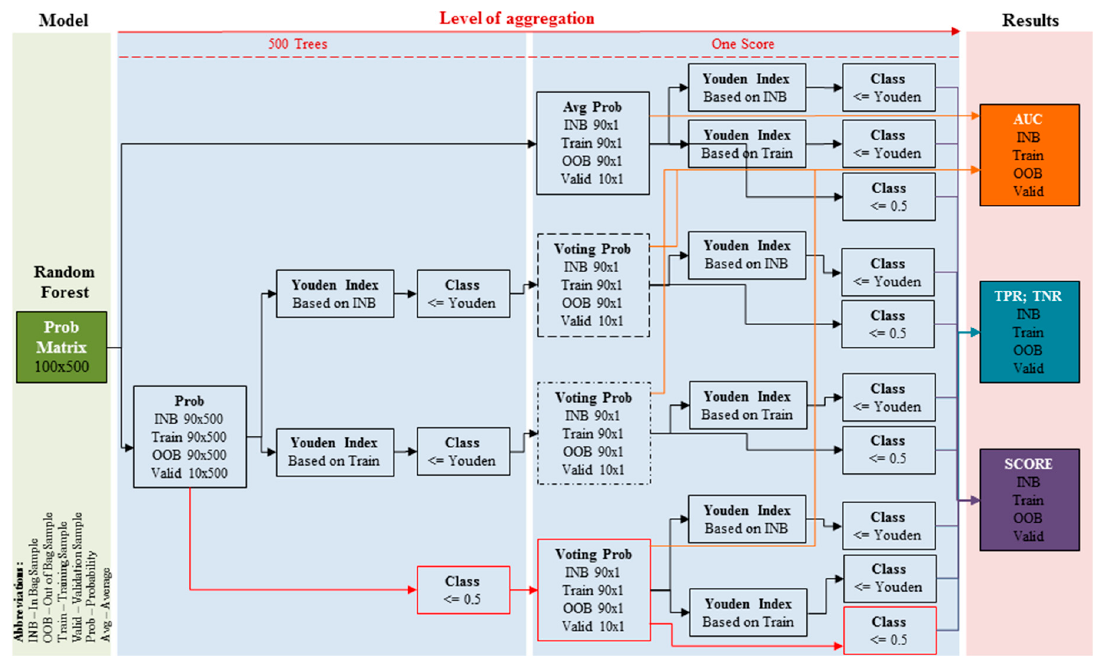
Figure 2. Possible approaches for probability and class determination.